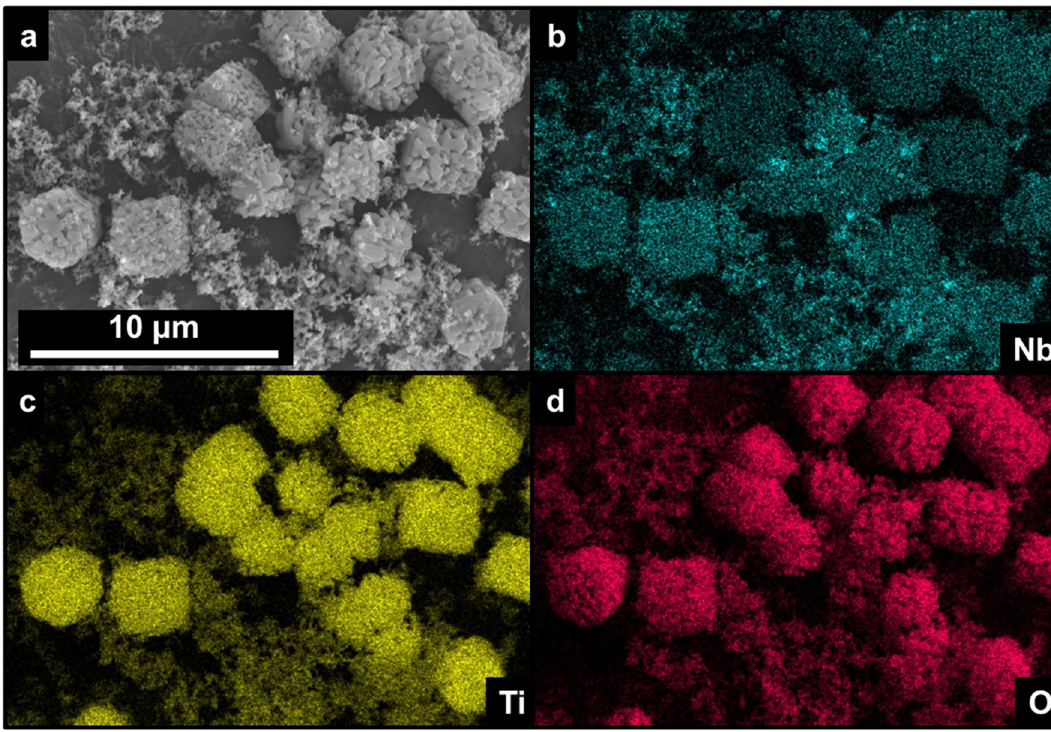
Figure 4. ( a ) SEM micrograph of NTO900 showing overall particle morphology coupled with EDS elemental chemical mapping taken at the Nb ( b ), Ti ( c ), and O ( d ) edges, corroborating Nb doping into TiO 2 . Images generated using AZtec (Oxford Instruments).